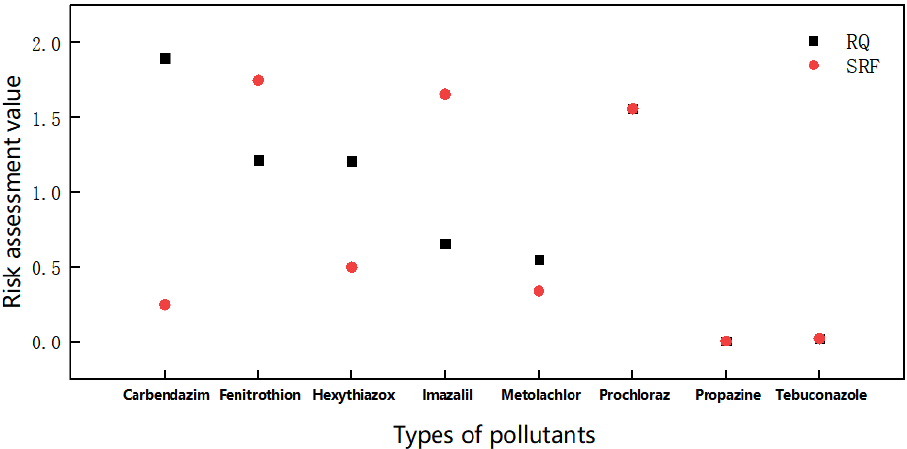
Figure 2. Environmental risk level assessment of residual pesticides using RQ and SRF.